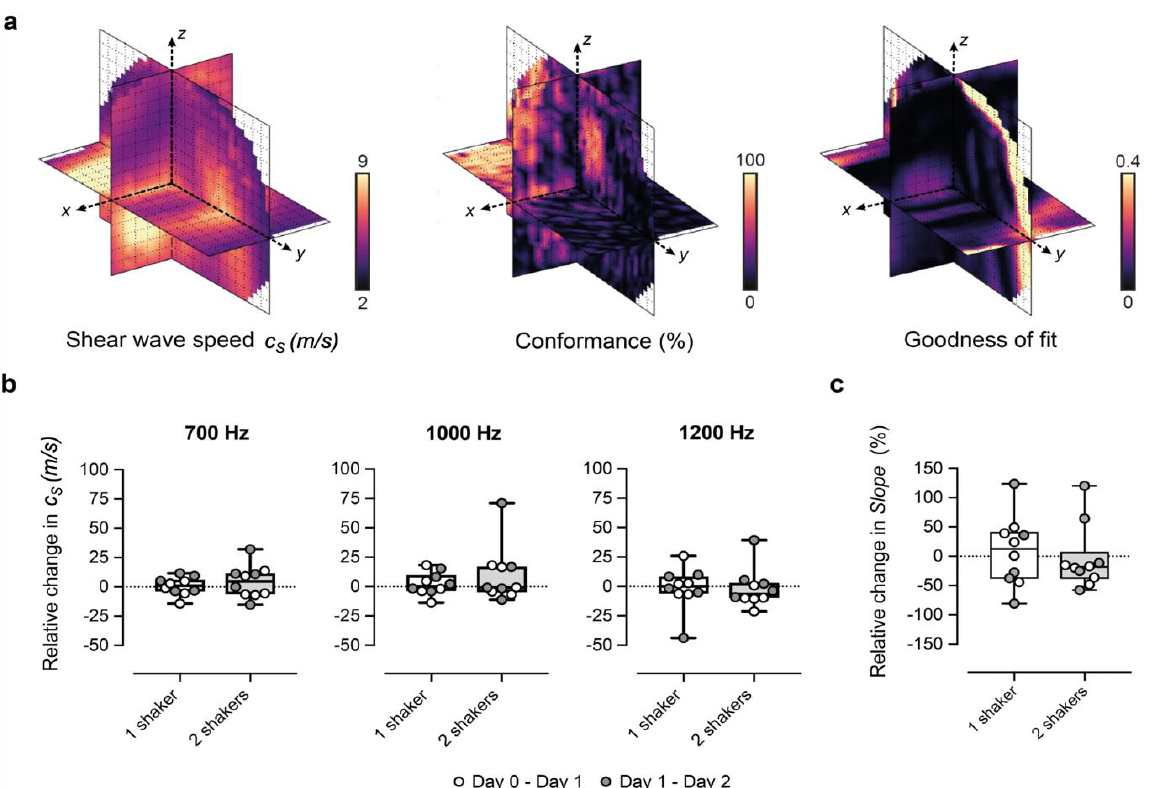
Figure 2. Performance of our 3D-vibrational shear wave elastography (3D-VSWE) platform. ( a ) shows orthogonal slices through 3D maps of c s , C and GoF across the tumour. Conformance is a measure of the percentage of the vibrational frequency detected at the vibrational source frequency and can be mapped to allow the user to assess the penetration of the shear waves during the positioning of the contactors. Similarly, the average Goodness of Fit (GoF) across the tumour allows real-time assessment of the quality of the data that can be obtained. ( b ) and ( c ) show the percentage change in spatial-median c s and slope, respectively, between repeat measurements acquired 24 hours apart. Data shown were generated using 2 mm kernels with 0.5 mm spacing and one vibrational source.